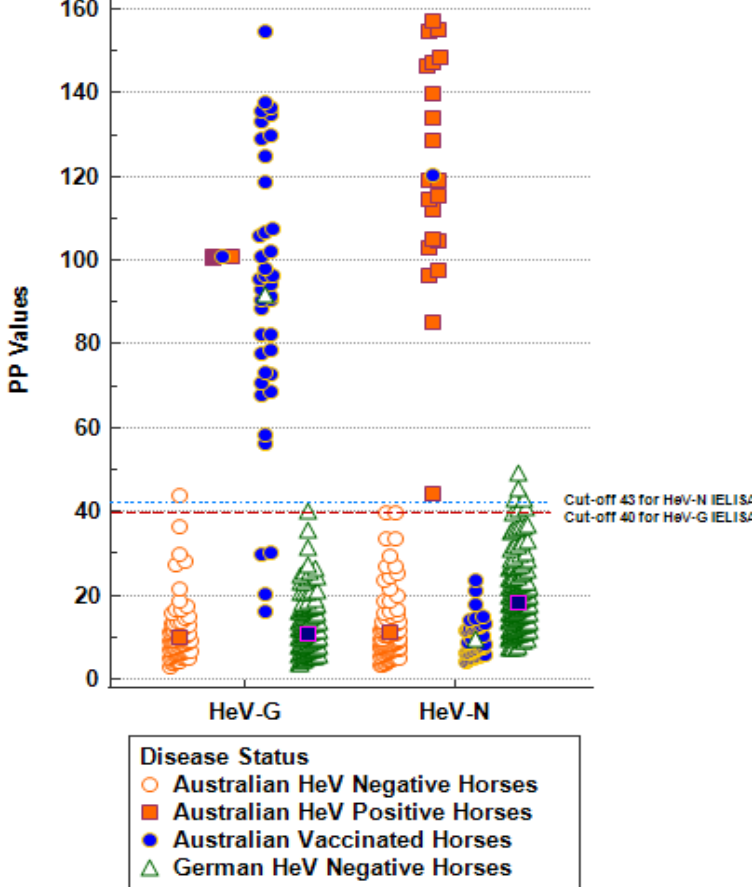
Figure 2. Diagnostic sensitivity (DSe) and specificity (DSp) of HeV-G and HeV-N assays were established using 105 HeV-negative Australian horses, 21 HeV-infected Australian horses, and 40 HeV G-vaccinated Australian horses. The mean values are shown in the middle of the dot plots. Results for 288 HeV-negative German samples and 21 HeV-positive Australian samples were used to derive assay-specific cut-offs.